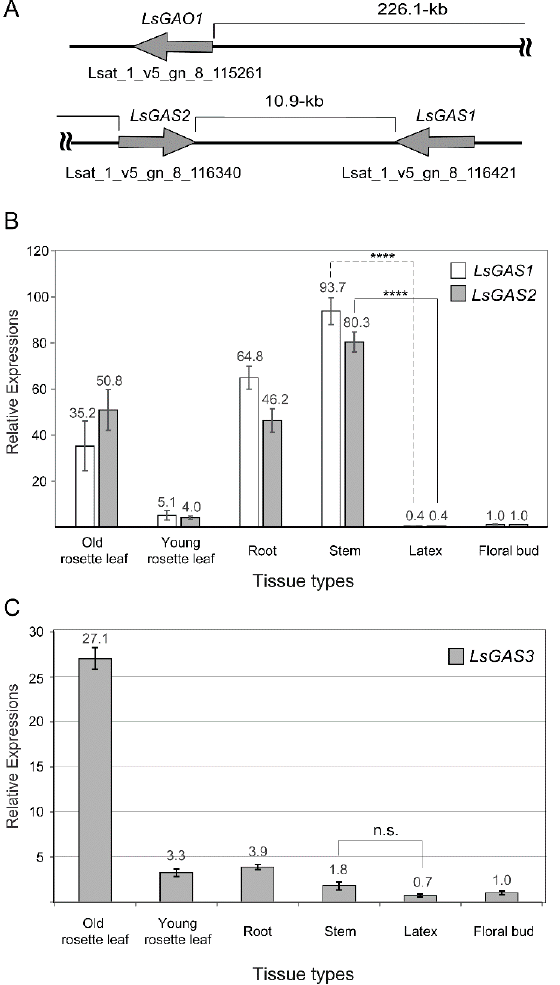
Figure 2. Genomic cluster and expression analysis of LsGAS . ( A ). Schematic representation of LsGAS1 , LsGAS2 , and LsGAO1, retrieved from Phytozome. ( B , C ). qPCR analyses of LsGAS1 /2 ( B ) and LsGAS3 ( C ) in various lettuce tissues. Young rosette leaves were collected 10–14 days after germination; old rosette leaves were collected 4–6 weeks after germination. The transcript level in floral buds was set to one, and all other values were relative to the floral bud transcript level. Stem samples used whole stem tissues including latex. Data are means ± S.D. ( n = 4). **** indicates a p value of < 0.0001; n.s. indicates no statistical significance, p value